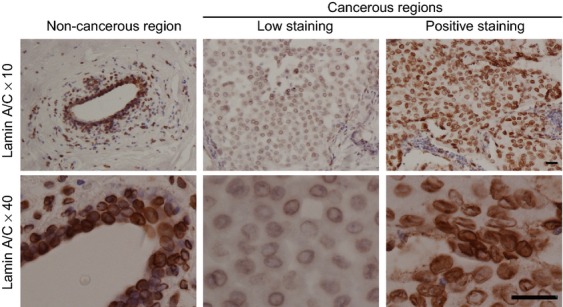
Immunohistochemical staining of lamin A/C. Specimens of breast tumor were stained using anti-lamin A/C pAbs. Representative cases including noncancerous (left) and cancerous regions (middle and right) are shown. The upper panels were obtained at lower magnification than the lower panels. Bar, 50 μm.